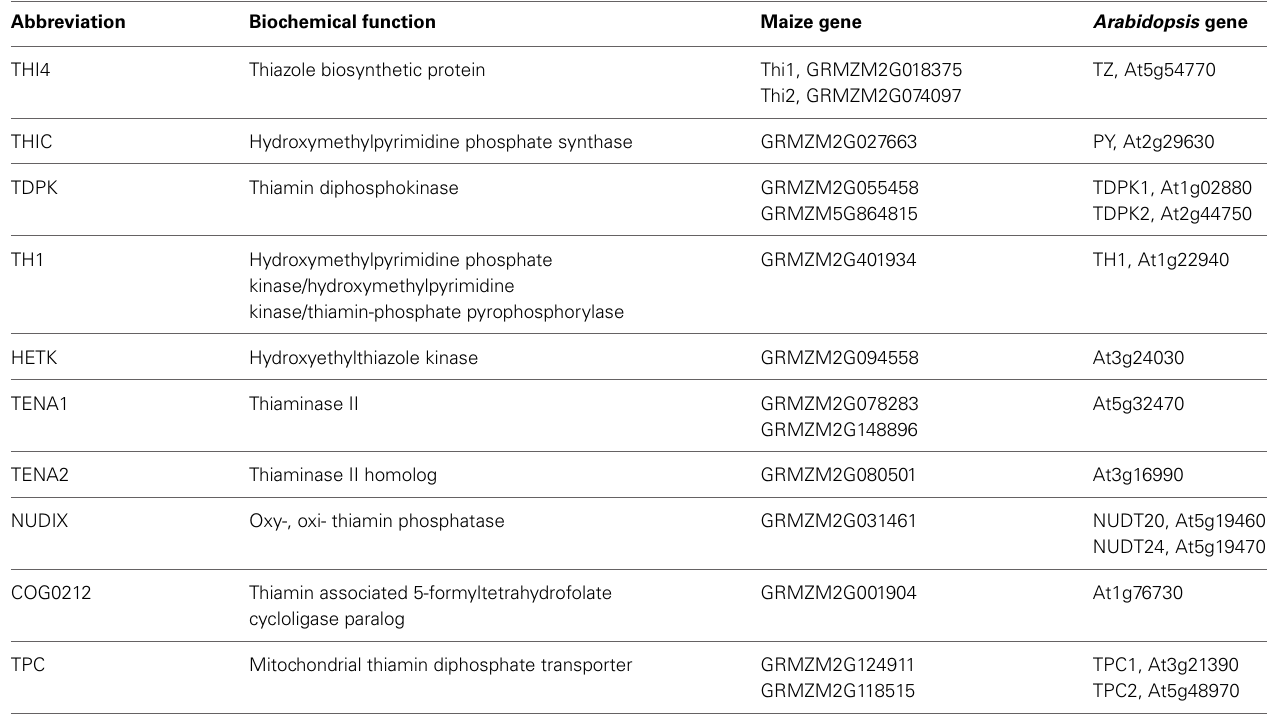
Table 1 | Thiamin biosynthetic pathway genes of maize and Arabidopsis